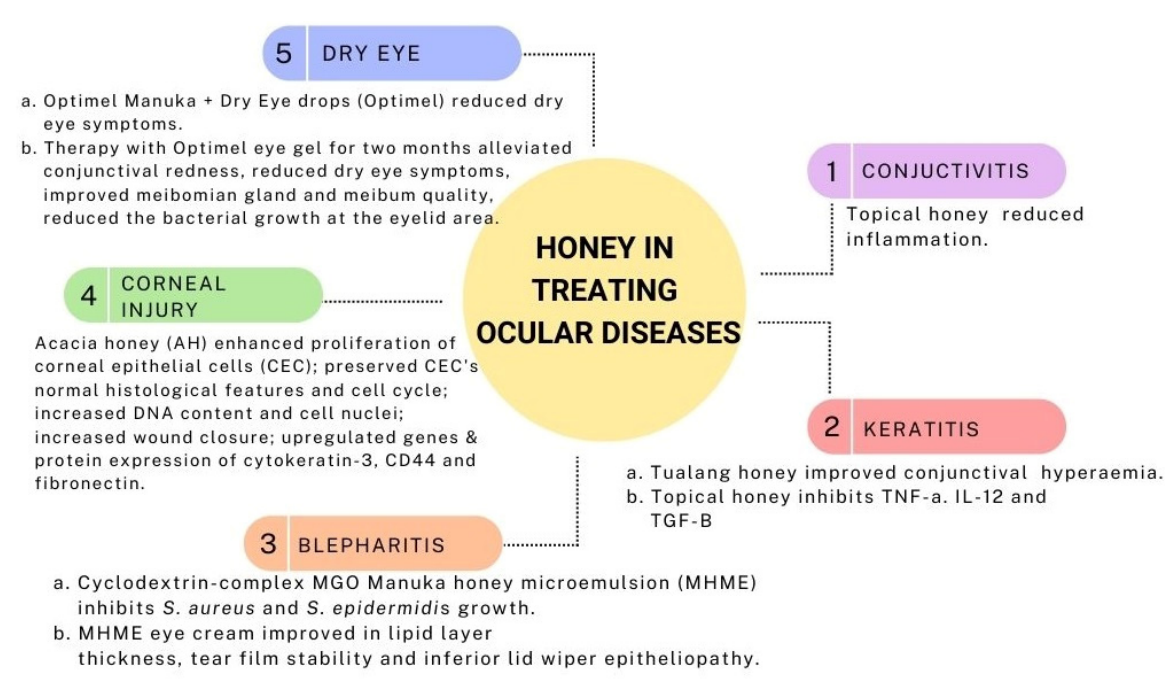
Figure 3. Medicinal values of honey in treating ocular